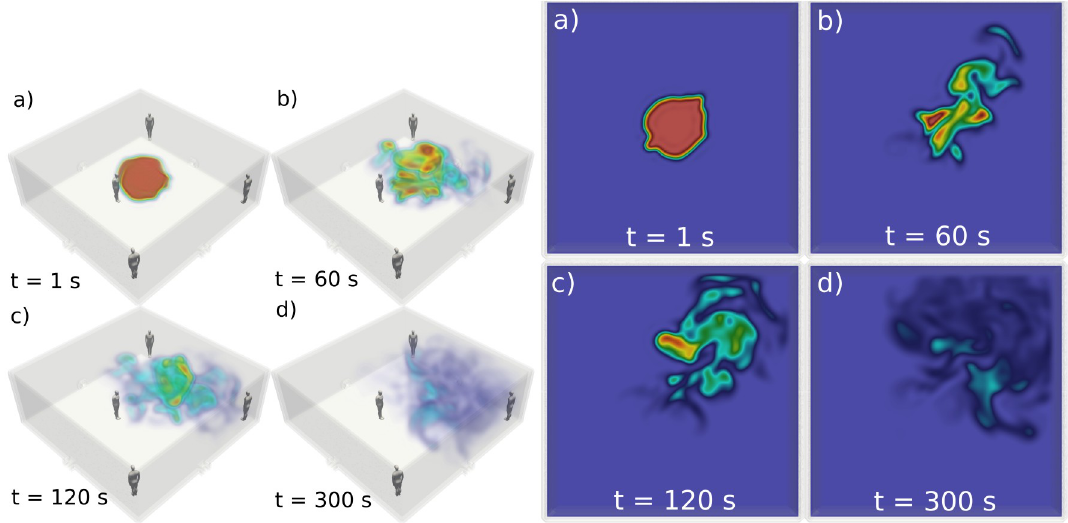
Fig 1. The figure on the left depicts the time-evolution of the concentration (arb. units) of an aerosol plume (red region) emitted by an infected person at the center of a room, where t = 0 s denotes the inception of the plume. The results displayed here were obtained in a CFD simulation incorporating the (turbulent) air currents generated by a typical room ventilation setup. The ventilation effectively dilutes, spreads and gradually removes the plume. The figure on the right illustrates this concentration data at the middle- cut plane with respect to the room height. The results in these figures indicate that in the event of an ideal ventilation, the plume can be considered to be subjected to isotropic turbulence. Therefore, the inception and mixing of the aerosol plume with the surrounding air can be modeled within a reasonable accuracy as a diffusion event with concentration sources and